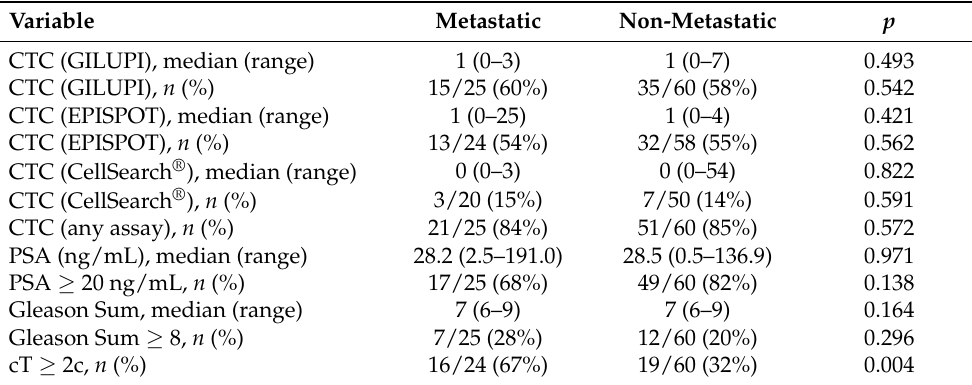
Table 2. Baseline CTC counts detected using the GILUPI CellCollector, EPISPOT assay and CellSearch ® system and clinical characteristics of 85 patients with localized PCa at baseline, ac- cording to the development of metastases during the follow-up period.